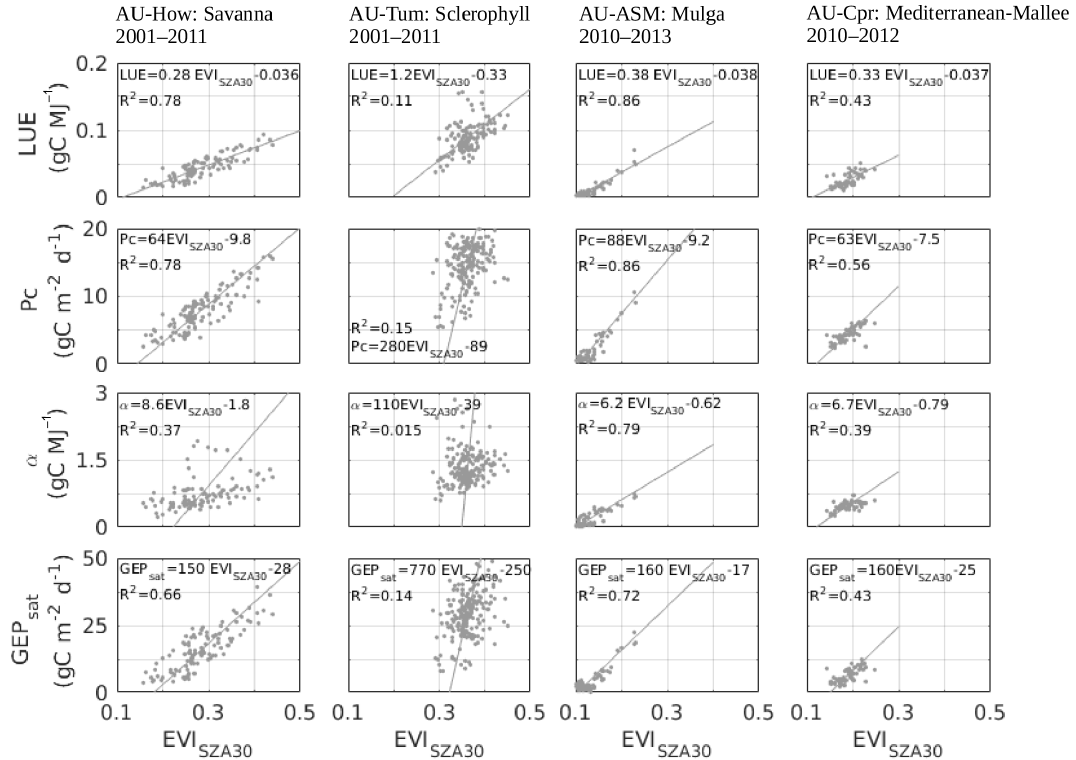
Figure 6. Relationships between 16-day mean values of (a) light use efficiency (LUE; gCMJ − 1 ) , (b) photosynthetic capacity (Pc; gCm − 2 d − 1 ) , (c) ecosystem quantum yield ( α ; gCMJ − 1 ) , and (d) GEP at saturation light (GEP sat ; gCm − 2 d − 1 ) , and MODIS fixed solar zenith angle of 30 ◦ enhanced vegetation index (EVI SZA30 ) . Four key Australian ecosystem sites, from left to right (columns): AU-How savanna, AU-ASM mulga, wet sclerophyll forest of AU-Tum, and AU-Cpr